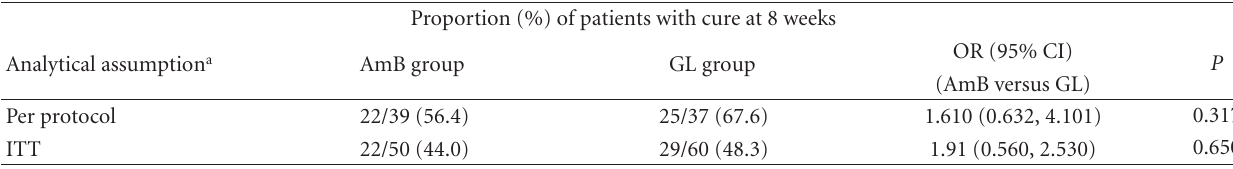
Table 2: Comparison of therapeutic response rates in the studied groups using the intention-to-treat approach and per-protocol analysis. Proportion (%) of patients with cure at 8 weeks